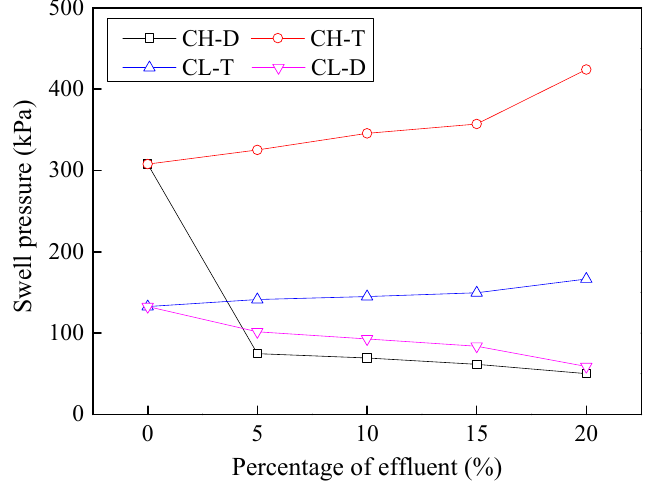
Figure 12. Effects of industrial effluents on swell pressure of cohesive soils.